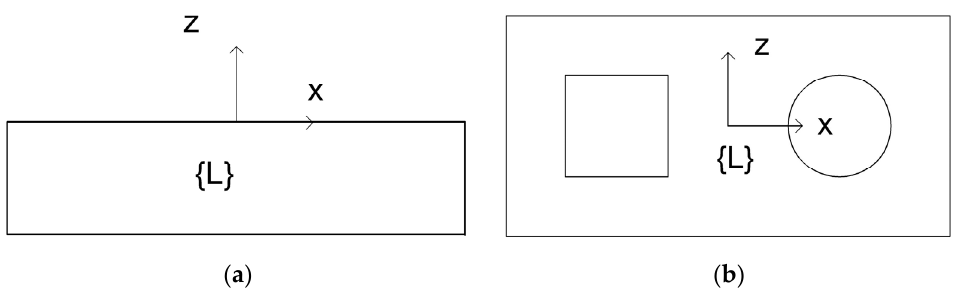
Figure 3. Side ( a ) and top ( b ) faces of pick up and placement bases. The placement base was placed at the distance of 50 mm from the center of the {L} (pick up position) and the “place position” distance of 100 mm from “pick up position”, i.e., 50 mm from the center of {L}.